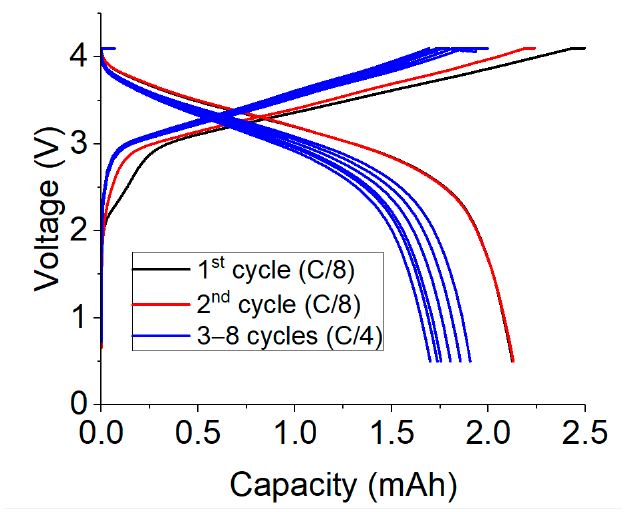
Figure 10. Typical charge–discharge curves for laboratory pouch cell of the system “LiNi 0.8 Co 0.15 Al 0.05 O 2 —CoGe 2 P 0.1